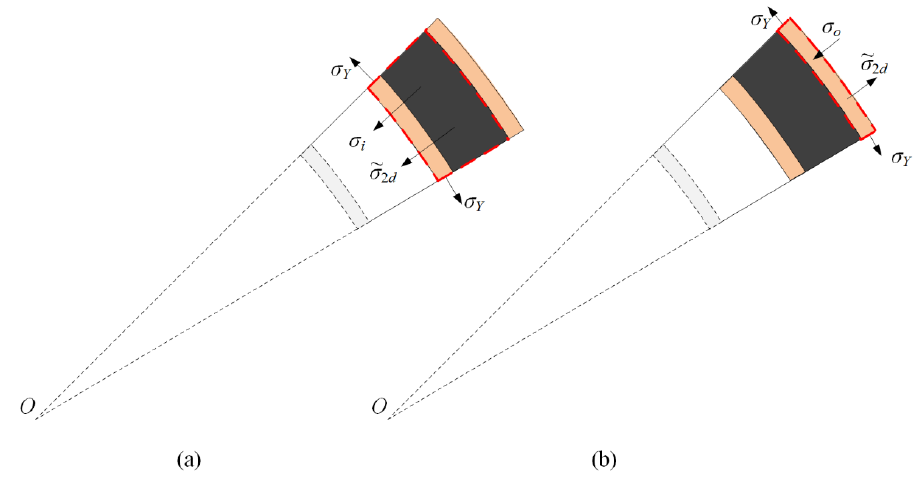
Figure 9. Stress analysis for the sandwich-walled ring in stage I. ( a ) The inner face-sheet and the core, and ( b ) the outer face-sheet.